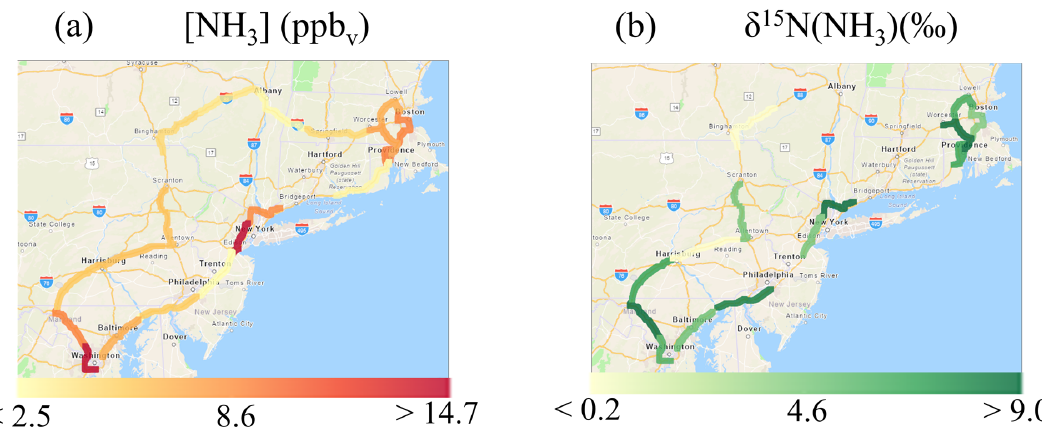
Figure 6. Spatial maps of (a) mean [ NH 3 ] (ppb v ) and (b) δ 15 N ( NH 3 ) (‰) from on-road collections in the northeastern USA. Each color represents one concentration or isotope measurement for NH 3 collected over a highway segment at an approximate 1h resolution using an acid-coated denuder. Note that there are fewer reported δ 15 N ( NH 3 ) values than [ NH 3 ] , because some samples had an elevated blank (i.e., f Blank > 30%) and were not measured for δ 15 N ( NH 3 ) . Images were created using ArcGIS Copyright © 1995–2019